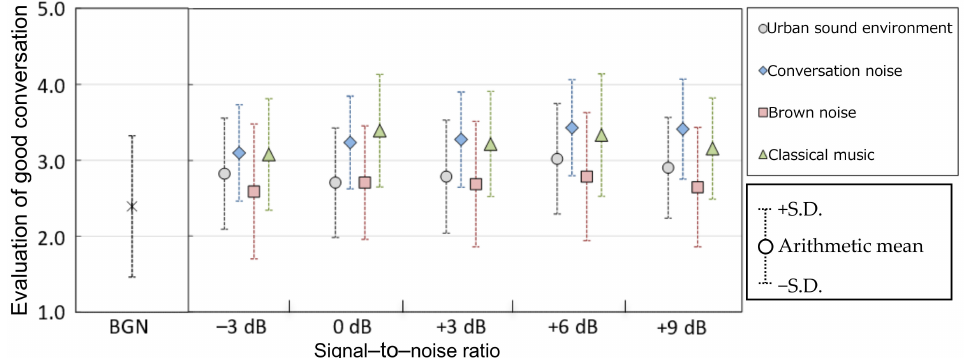
Figure 2. Evaluation of a “good conversation” for each sound environment. The plots in this figure represent the arithmetic mean, and the error bars indicate the standard deviation.